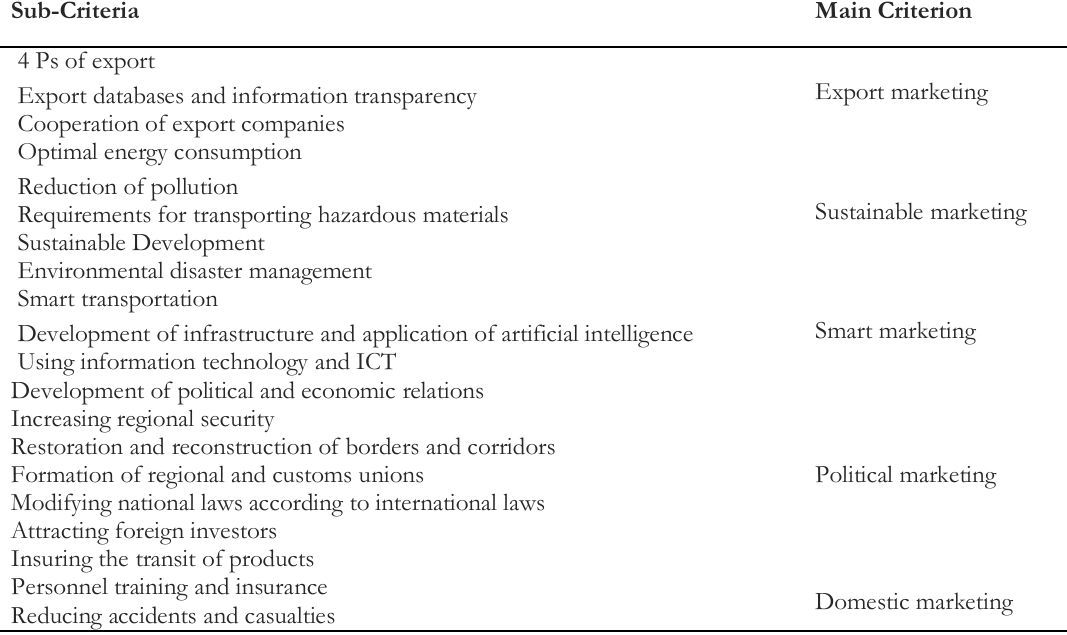
Table 13. The result of the qualitative part of grounded